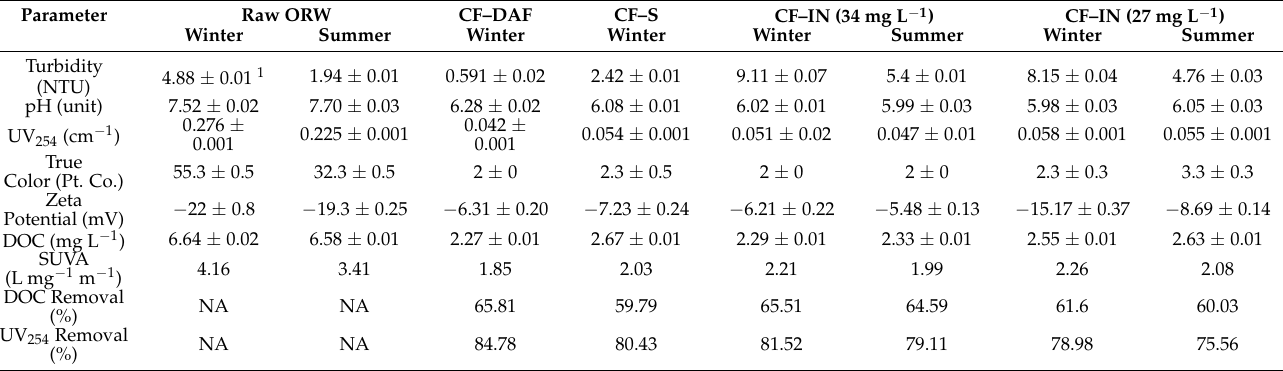
Table 2. Water Quality Data for Raw and Pretreated